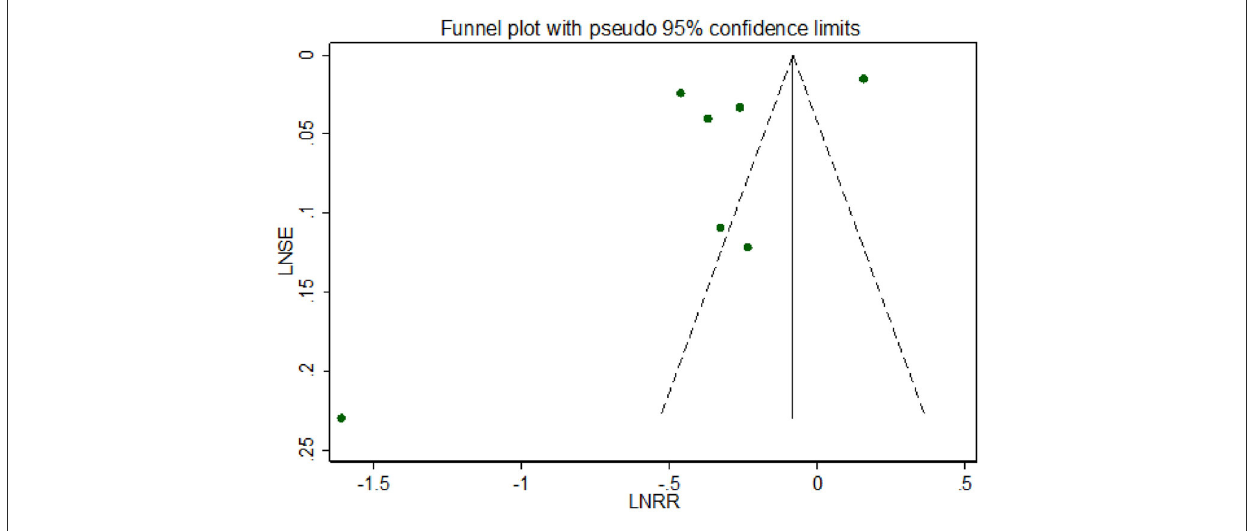
FIGURE5 Funnel plot for all-cause dementia in gout